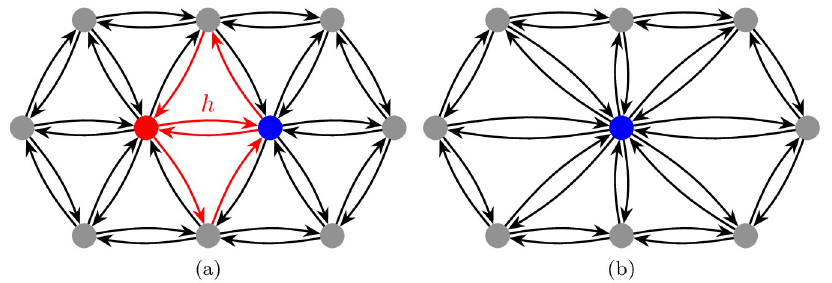
Fig 4. The edge contraction operation. (a) The two candidate vertices, and (b) the mesh after contracting the corresponding edge. The colored halfedges (red) and their incident triangles are marked as